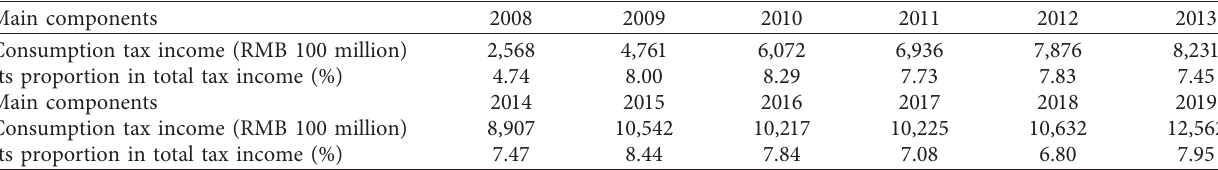
Table 5: Proportion of domestic consumption tax income in total tax income for the indicated year